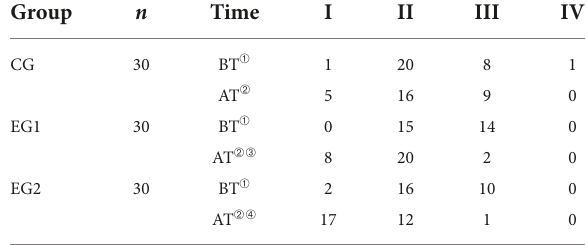
TABLE 5 Three groups of patients brain stem evoked potential grading score ( ¯ x ± s, control group n = 30, experimental group 1 n = 30, experimental group 2 n =